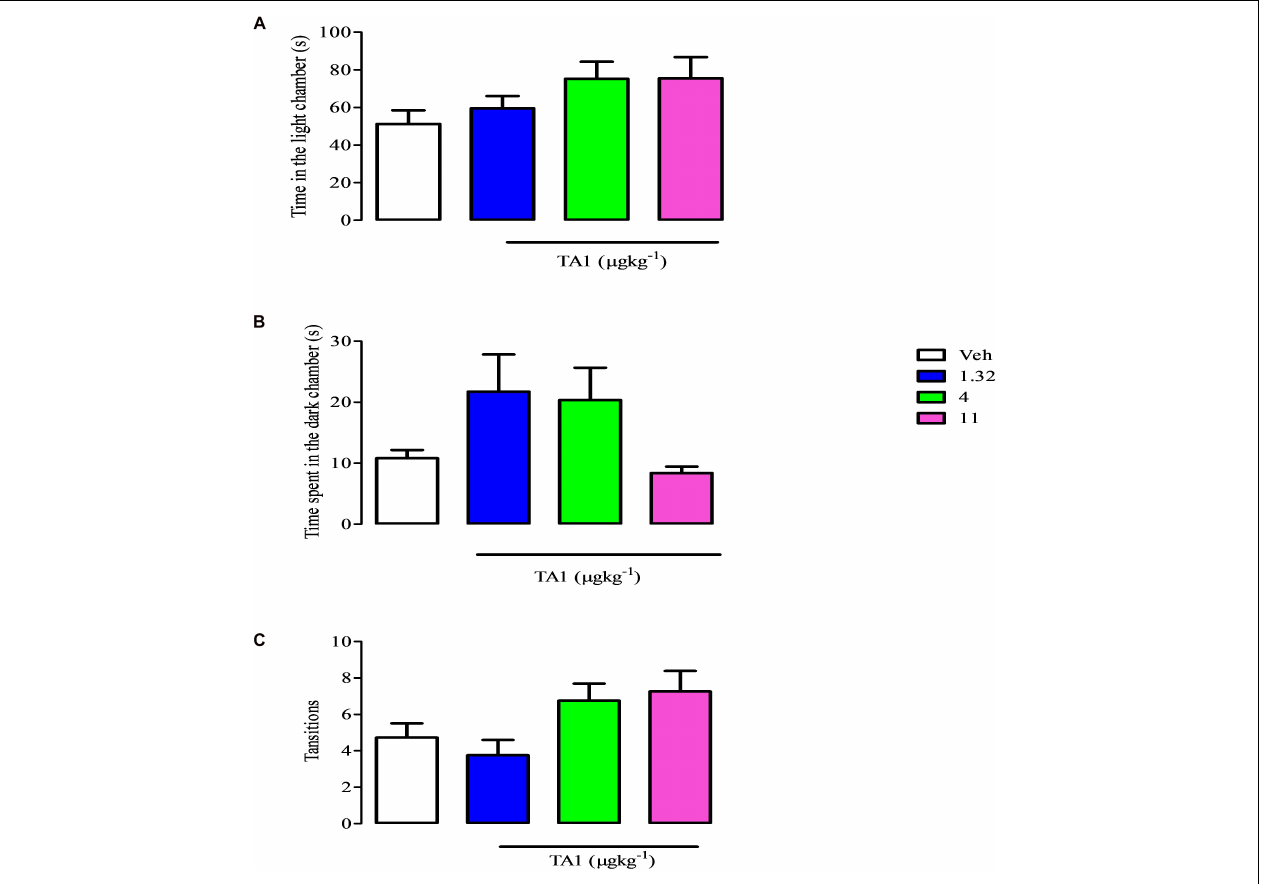
FIGURE 5 | TA1 does not show anxyolitic-like effects. The light dark paradigm was carried on mice received 1.32, 4 and 11 µ gkg − 1 TA1 or vehicle (Veh) as described in Methods. Results are expressed as the means ± SEM of measurements relative to 10 mice. Mice behaviors were scored for 300 sec and included (A) the duration of time spent in the light chamber, (B) the latency to the first step into the dark compartment, (C) the number of full-body transitions between